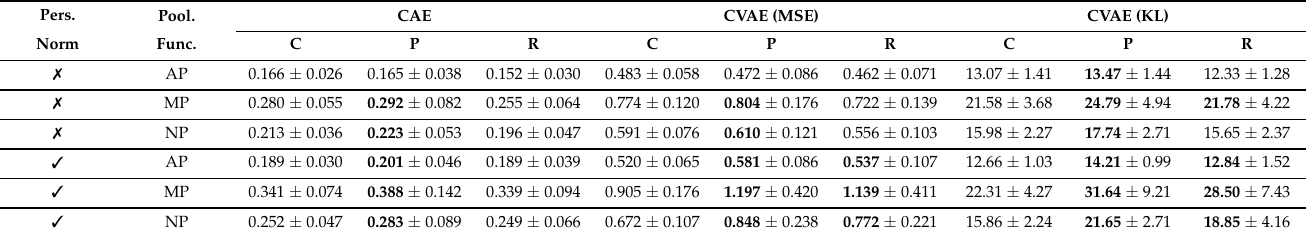
Table 14. Median anomaly scores for the discrimination between sessions that correspond to stable (C), pre-relapsing (P) or relapsing (R) condition, for both CVAE and CAE global models. Pers. Pool.